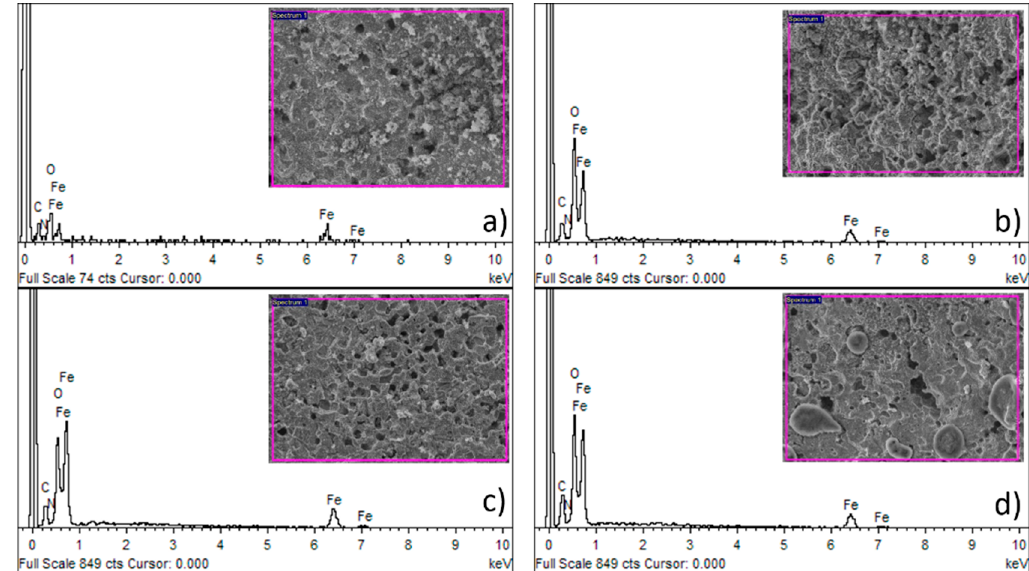
Figure 11. The chemical composition of the surface of ( a ) pure Fe; ( b ) Fe-PEI1; ( c ) Fe-PEI2; and ( d ) Fe-PEI3 after 12 weeks of corrosion in simulated body fluids studied by the EDX method.